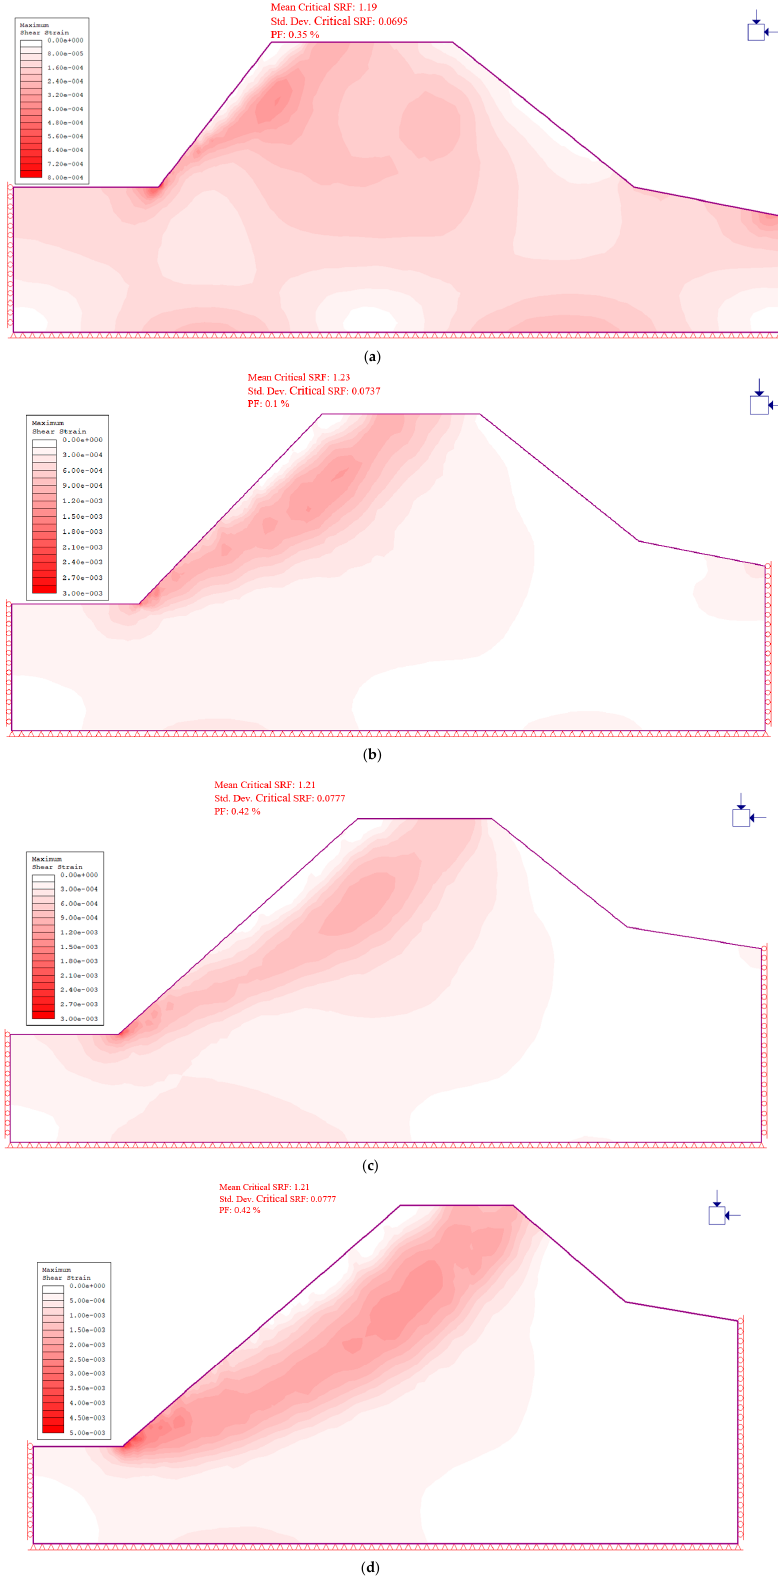
Figure 8. Optimized slope angles for various excavation depths at 50 m distance from the shoreline. ( a ) 20 m depth, 52° slope angle; ( b ) 30 m depth, 46° slope angle; ( c ) 40 m depth, 42° slope angle; ( d ) 50 m depth, 39° slope angle. The stability analysis also incorporated the statistical analysis function of Phase 2 to eval ‐ uate the slope probability of failure (PF). The PF is generated by the analysis software when the statistical option is selected in project settings. A standard deviation is set for material properties to allow the statistical calculation. From Figure 8, the probability of failure is high for steep slope angles between 90° and 60°, after which it significantly reduces when the safety factor is ≥ 1. The graph gives a good visual impression of the stability of the slope, in that even when the safety factor is high, the steep slope angles present high probabilities of failure. In the dry condition, there is no significant difference in slope angle relative to distance from the shoreline. The data in Table 2 were used to plot the graph of variation of safety factor with slope angles, as shown in Figure 9 .